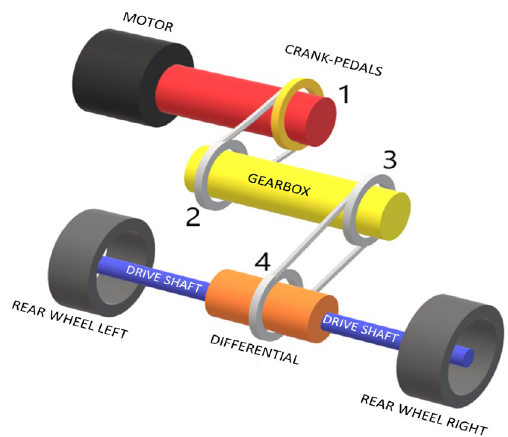
Fig.11 Scheme of the power transmission from the PU to the rear